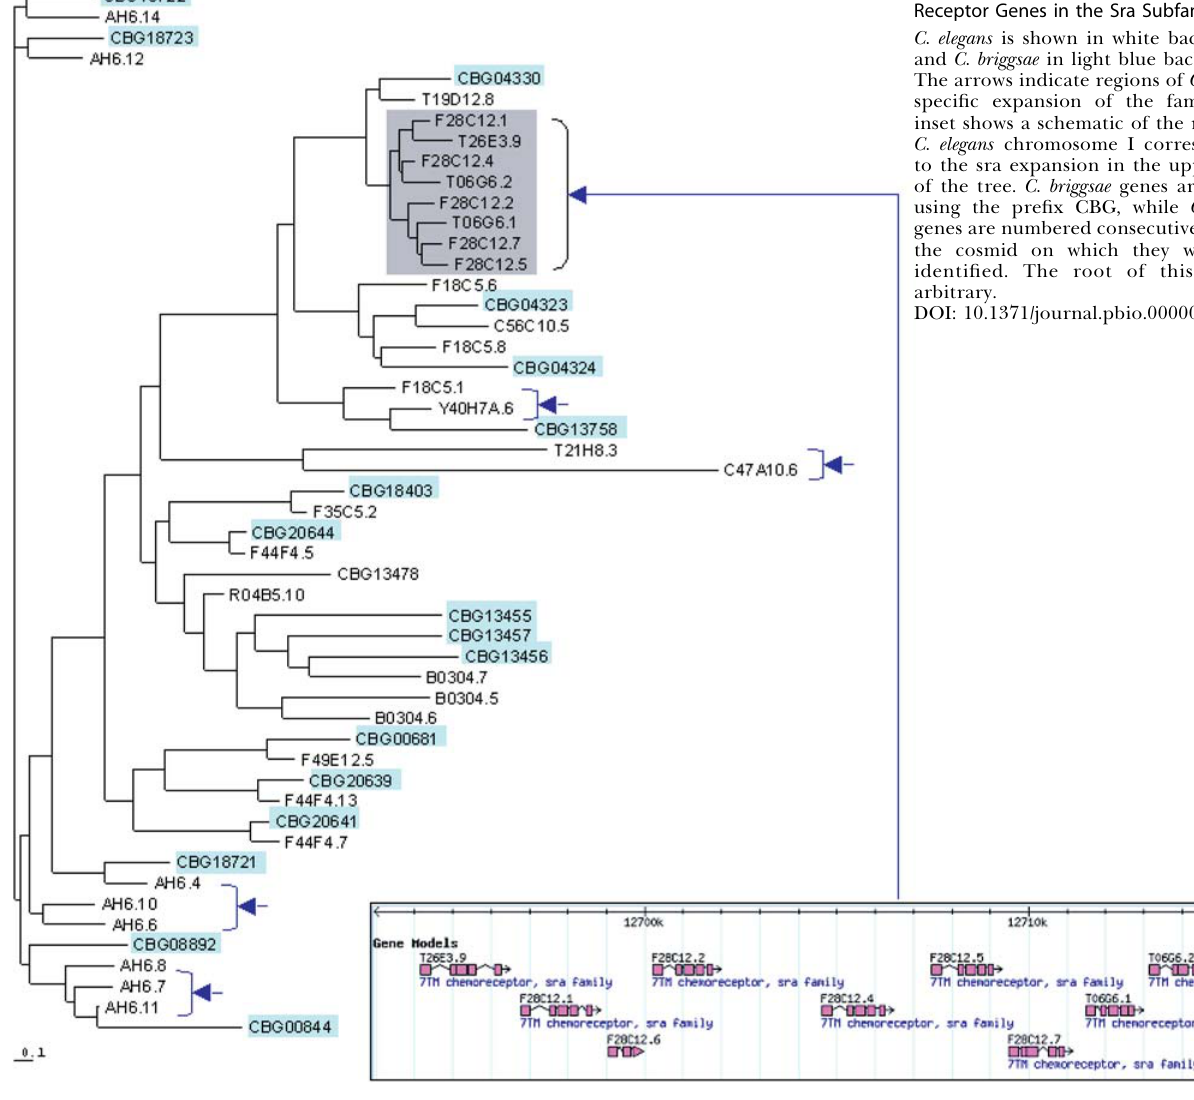
Figure 3. Tree View of All Chemosensory Receptor Genes in the Sra Subfamily C. elegans is shown in white background and C. briggsae in light blue background. The arrows indicate regions of C. elegans - specific expansion of the family. The inset shows a schematic of the region of C. elegans chromosome I corresponding to the sra expansion in the upper right of the tree. C. briggsae genes are named using the prefix CBG, while C. elegans genes are numbered consecutively across the cosmid on which they were first identified. The root of this tree is arbitrary. DOI: